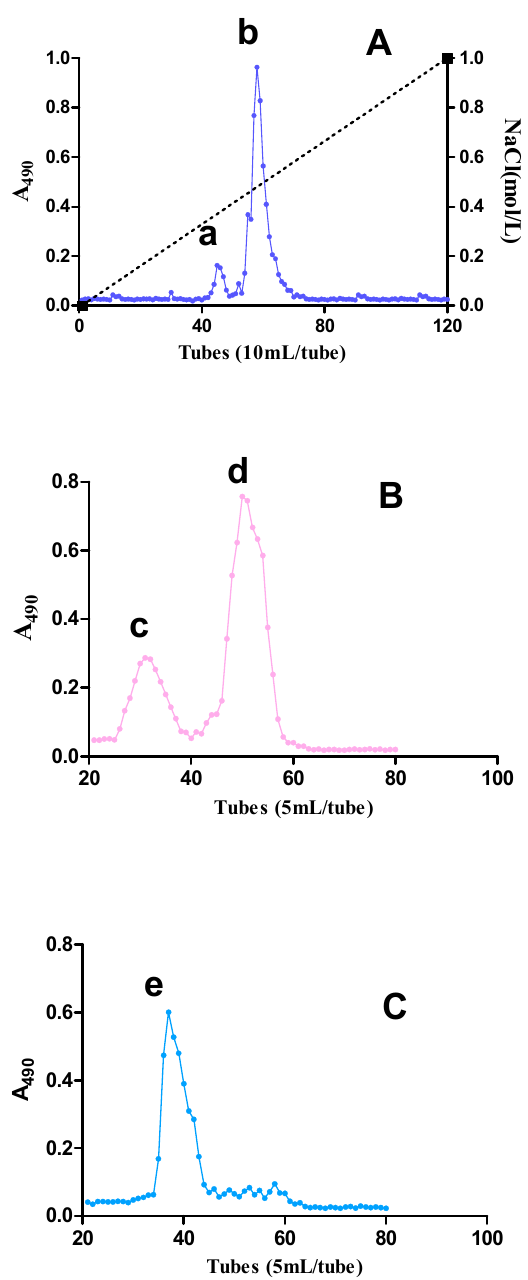
Figure 1. The carbohydrate elution profiles were monitored using the phenol–sulfuric acid assay (A490 is the absorbance at 490 nm). ( A ) Ion exchange chromatography elution profile of SJZDP: (a) SJZDP-I and (b) SJZDP-II; ( B ) Gel filtration elution profile of SJZDP-I: (c) SJZDP-I-I and (d) SJZDP-I-II; ( C ) Gel filtration elution profile of SJZDP-II: (e) SJZDP-II-I.